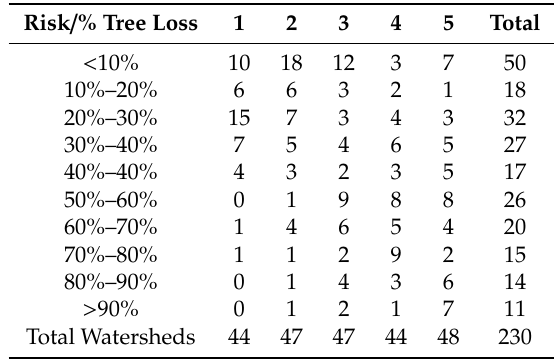
Table 2. Distribution of watersheds by estimated tree cover loss (up to 2015) and erosion risk.